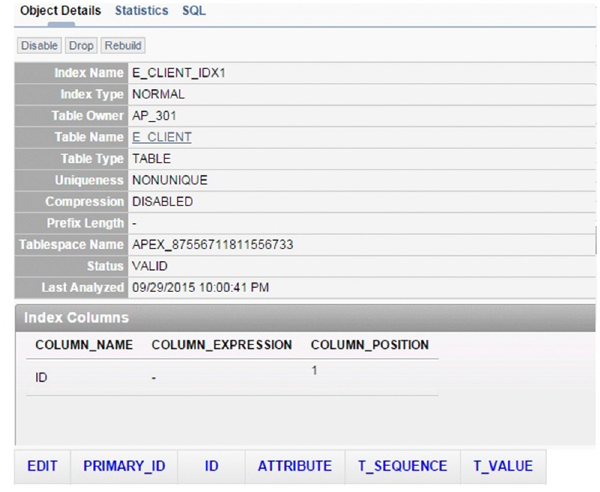
Figure 9. ID usage.